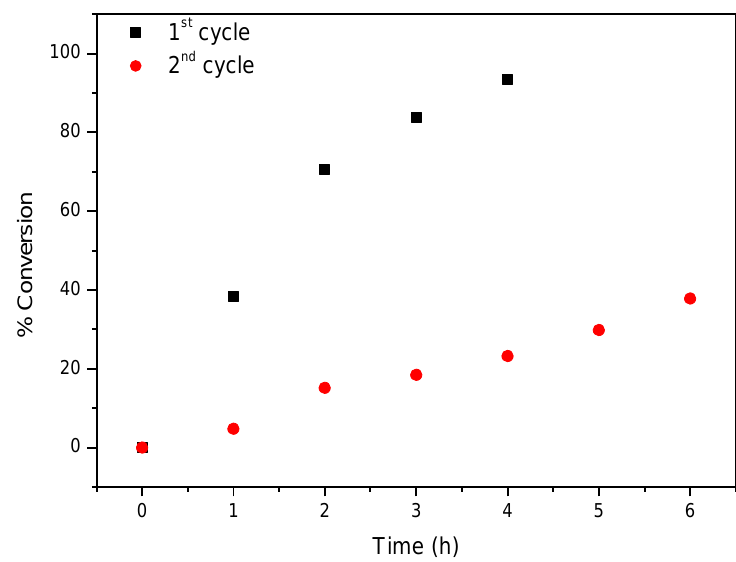
Figure 12. Oxidation of cyclooctene using CAT-4-Si as catalyst and TBHP as oxidant with additions of 0.5 eq. every 15 min.